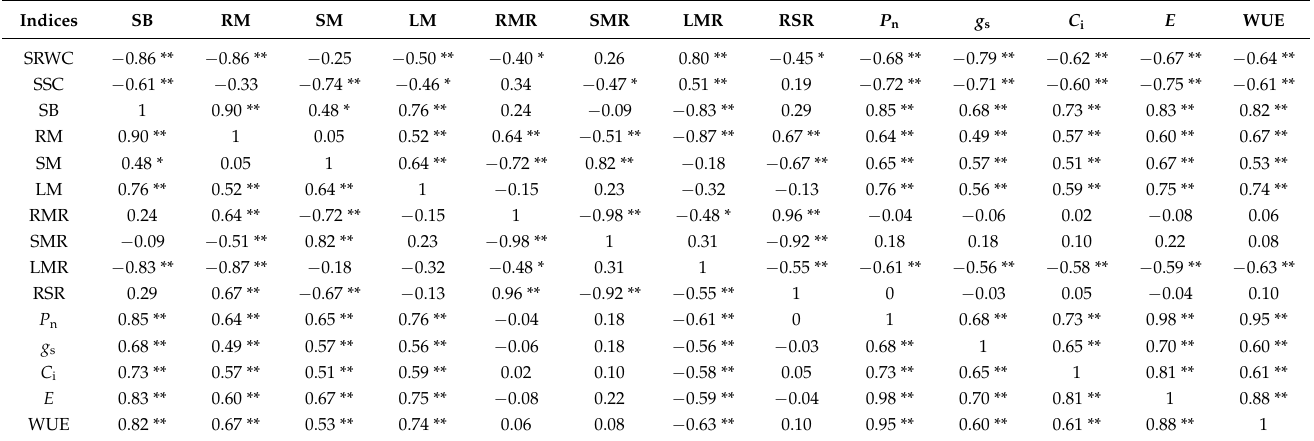
Table 2. Correlation coefficients between soil properties and R. pseudoacacia characteristics. SRWC: soil